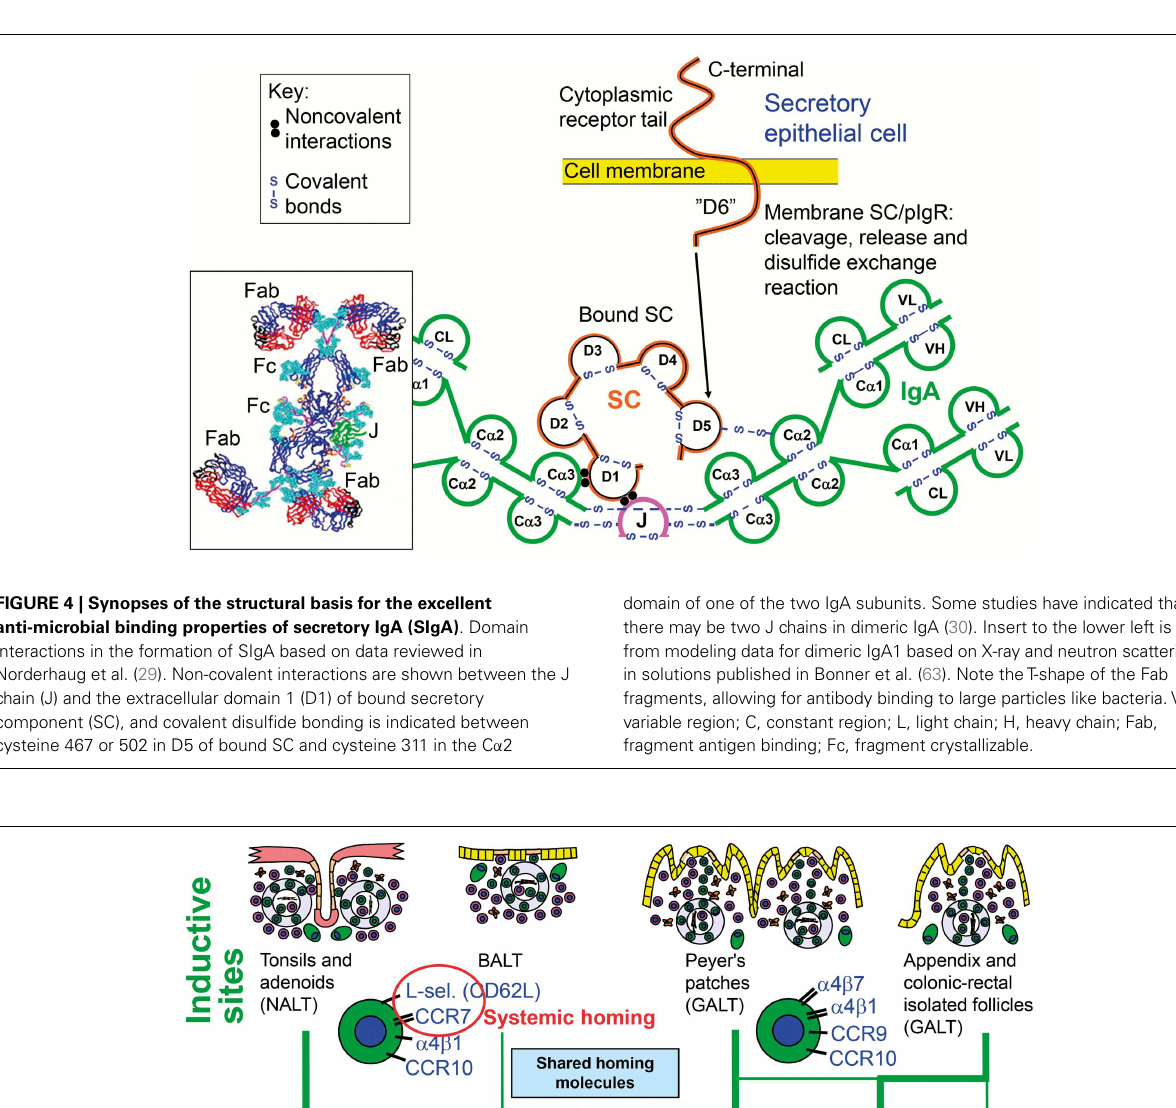
lymphoid follicles.The principal homing receptor profiles of the respective B-cell populations, and adhesion/chemokine cues directing extravasation at different effector sites, are indicated (pink and blue panels) – those operating in lactating mammary glands apparently being shared for NALT- and GALT-derived cells. Homing molecules integrating airway immunity with systemic immunity are encircled in red. Adapted from Brandtzaeg (51). MEC, mucosae-associated epithelial chemokine; TECK, thymus-expressed